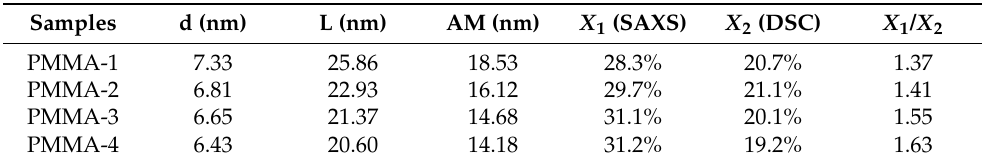
Figure 4. Lorentz-corrected SAXS curves ( A ) and one-dimensional correlation function curves ( B ) of PVDF/PMMA with different molecular weights of PMMA. Table 2. The lamellar thickness d , the long spacing L , thickness of the amorphous region AM and the crystallinity for the blends at 150 ◦